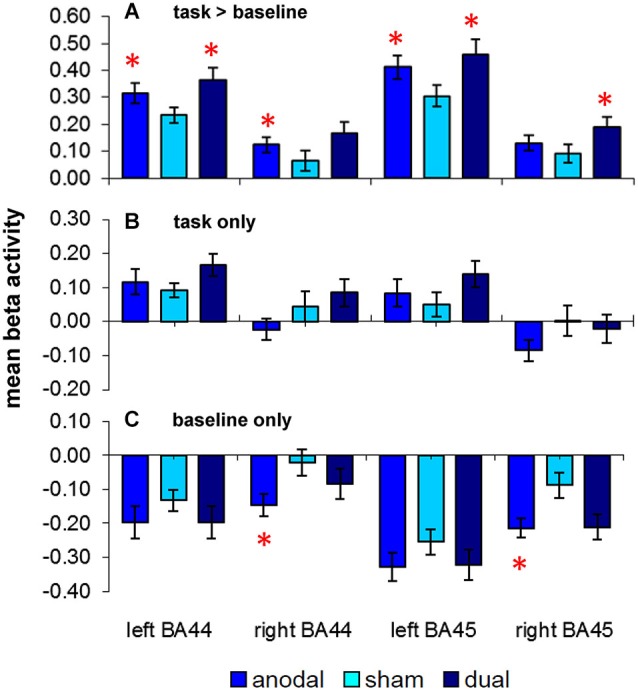
Results of the a priori region-of-interest (ROI) analysis in bilateral frontal regions (BAs 44/45): (A) upper panel depicts activity elicited by the semantic word-retrieval task as compared to motor speech trials (complex contrast) during the three stimulation conditions (anodal-, sham-, dual-tDCS). Lower panels show separate comparisons of activity elicited by (B) word-retrieval and (C) motor speech trials with the implicit baseline. Data show mean ± SEM, *p < 0.05 FDR-corrected corrected for multiple comparisons.